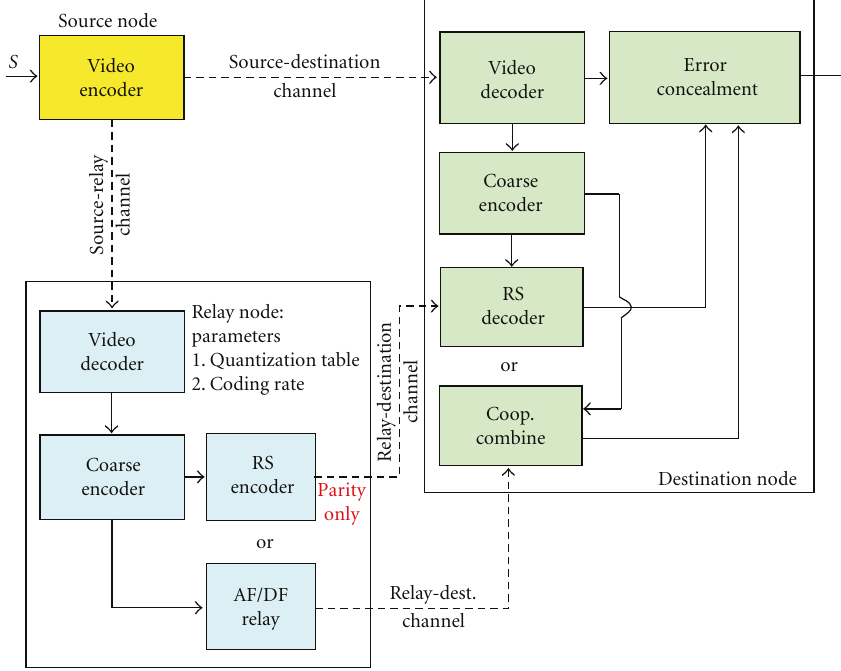
Figure 1: Proposed Video Cooperation